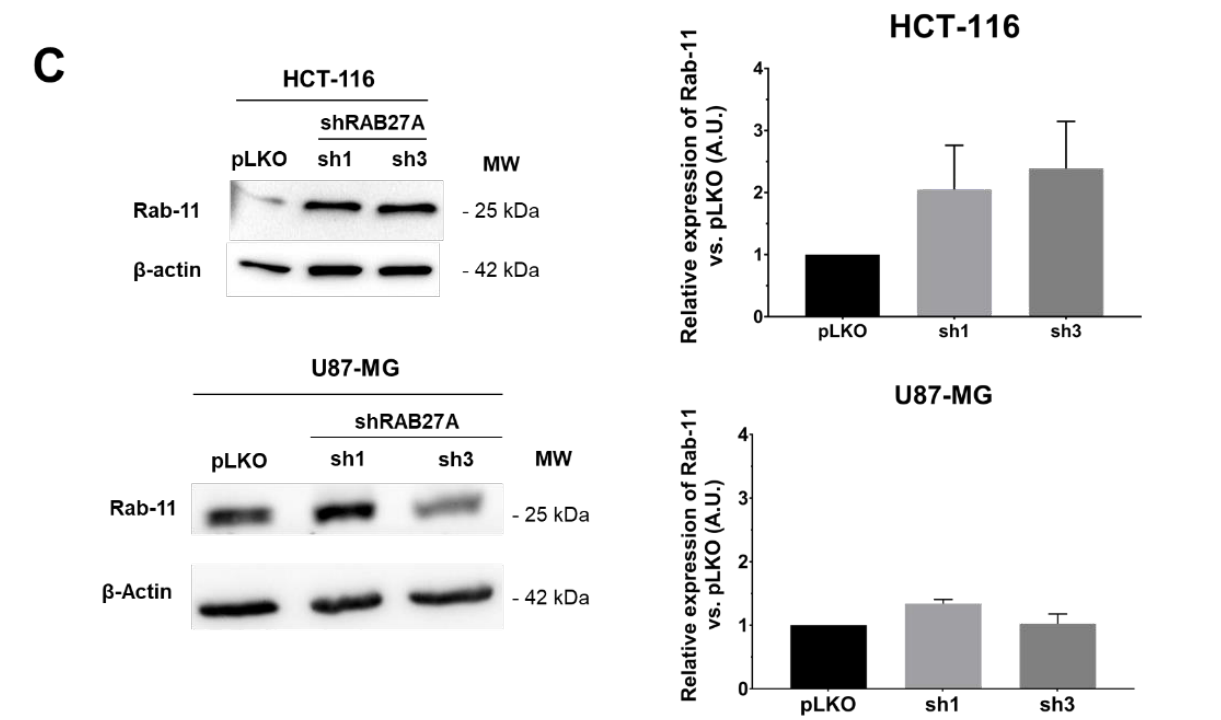
Figure 5. Analysis of the expression of other RAB-GTPases. ( A )—RAB27B and RAB35 expressions were analyzed by RT-qPCR assays in both HCT-116 and U87-MG cell lines. RAB35 was not detected in the U87-MG cell line. The Mann–Whitney test was performed on three independent experiments; * p < 0.05; ** p < 0.01; *** p < 0.001. ( B )—RAB27B and RAB35 expressions were assessed by Western blot in both HCT-116 and U87-MG cell lines. RAB35 failed to be detected in U87-MG. The Mann–Whitney test was performed in three independent experiments; ** p < 0.01; *** p < 0.001. ( C )—RAB11 expression was analyzed by Western blot in both HCT-116 and U87-MG cell lines. The Mann–Whitney test was performed on three independent experiments.